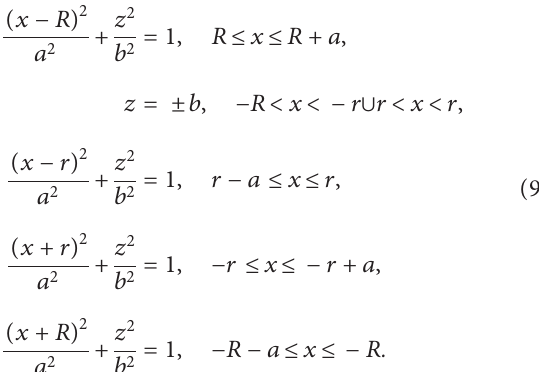
profile in Figure 7: (a) Assume that the vertical section of the rubber pad extruded part is semiellipse. (b) Assume that the sizes of the inner and outer semiellipses are the same. In Figure 7, the center of the rubber pad is selected as the origin to establish a rectangular coordinate system; the transverse half axis of the semiellipse is represented by a , and the vertical half axis is represented by b . The analytic geometric expression of the contour curve in Figure 7 is given